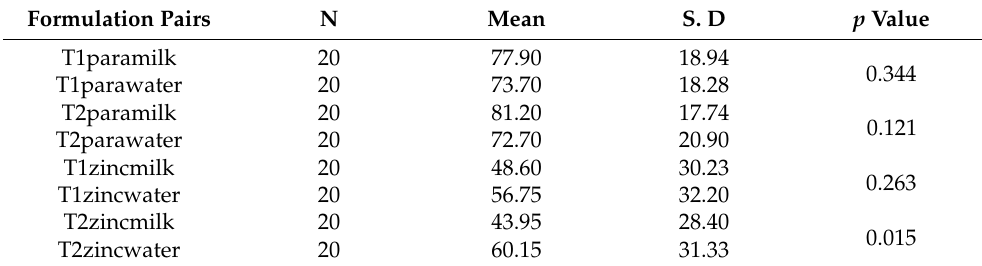
Table 2. P-values for the difference in mean taste-scores in the assessment of the taste-masking ability of infant formula milk. Note: T1 is the lactose platform, and T2 is the mannitol platform. Para = paracetamol.